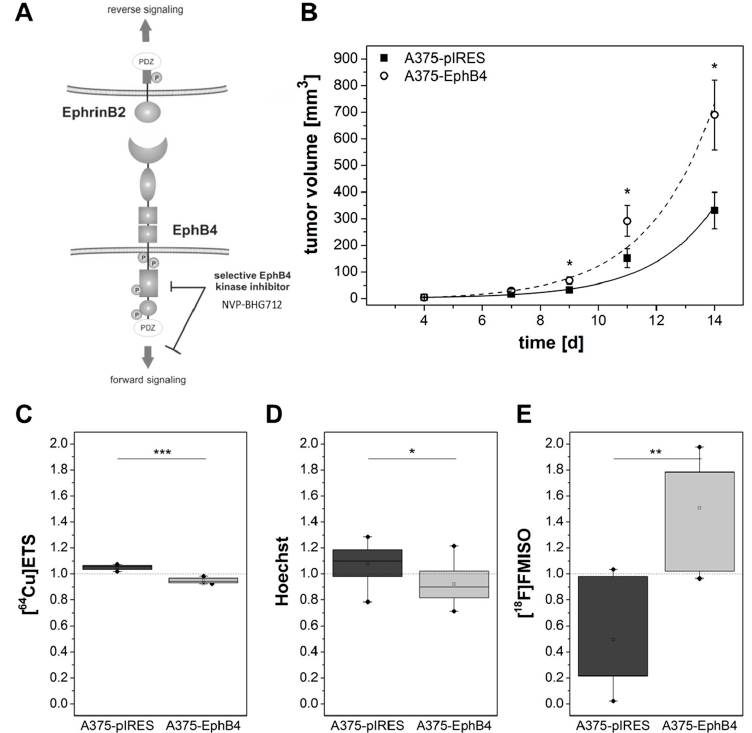
Figure 7. Influence of EphB4 forward signaling or EphrinB2 reverse signaling. ( A ) Interaction